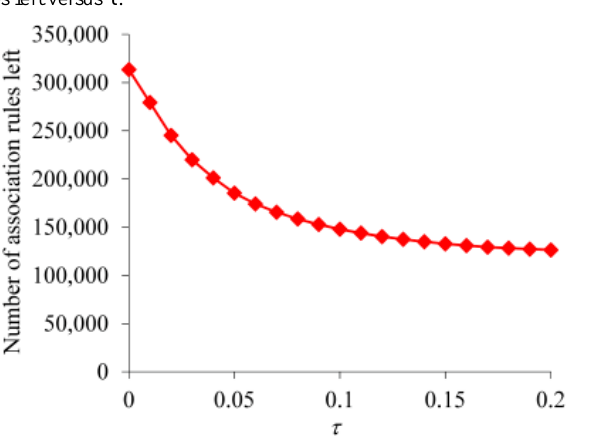
Figure 1. The number of association rules left versus τ